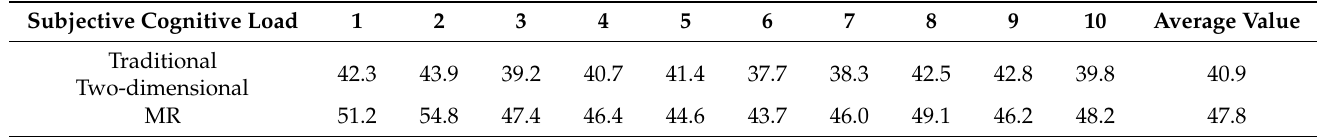
Table 6. Subjective Cognitive